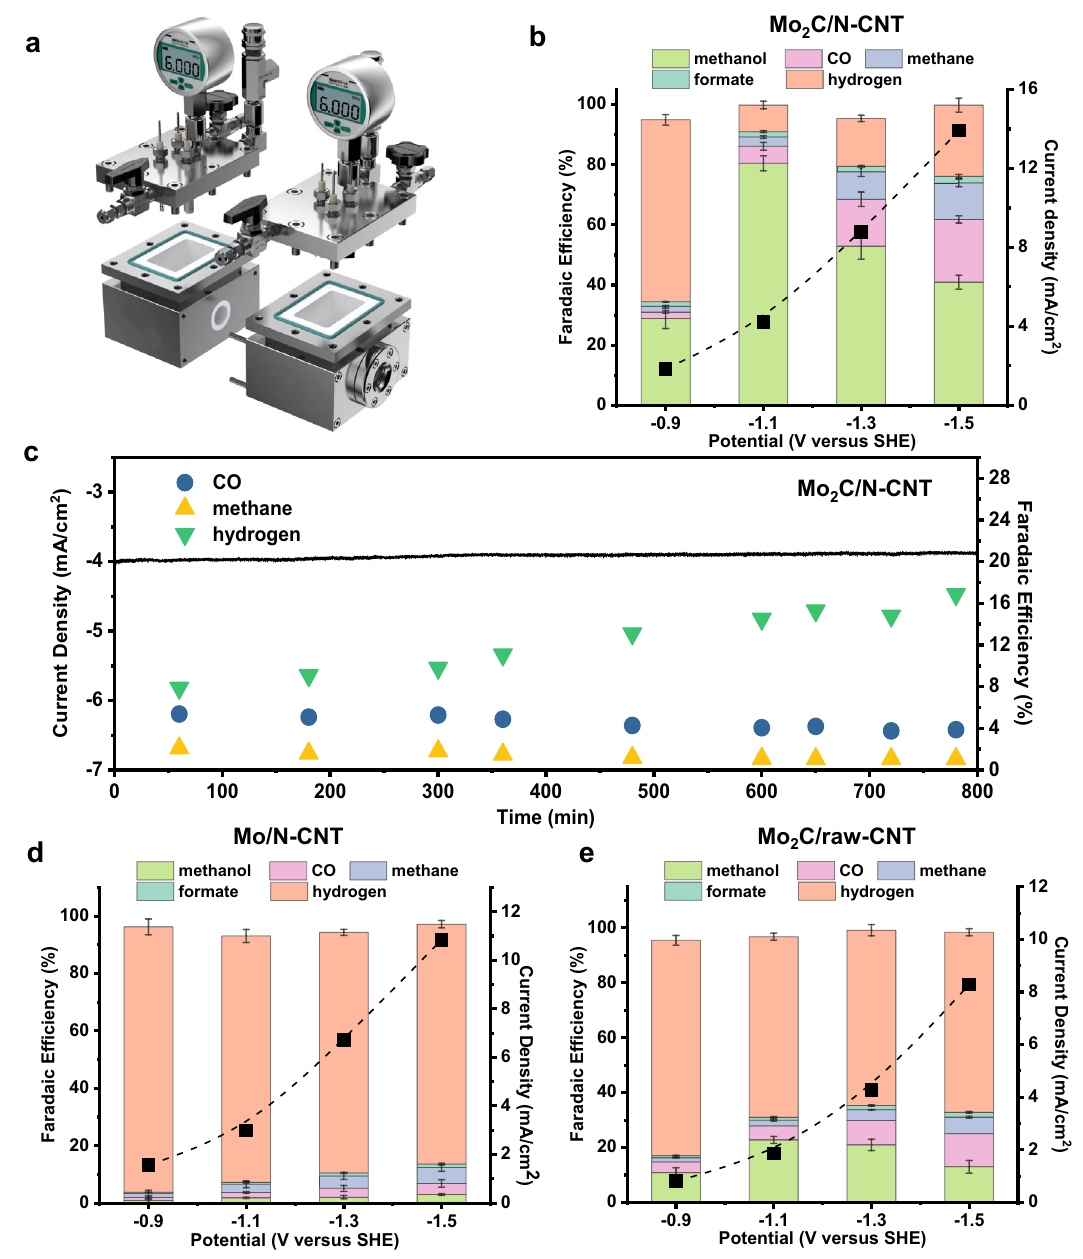
Fig. 2 | CO 2 RR performances of Mo 2 C/N-CNT and control samples. a Schematic of the high-pressure CO 2 RR system with 0.1M KHCO 3 as electrolyte. b Product distribution of Mo 2 C/N-CNT after 3h CO 2 RR under 40atm CO 2 at various poten- tials. c Current – time ( I – t ) curves of Mo 2 C/N-CNT under the temporal evolution at